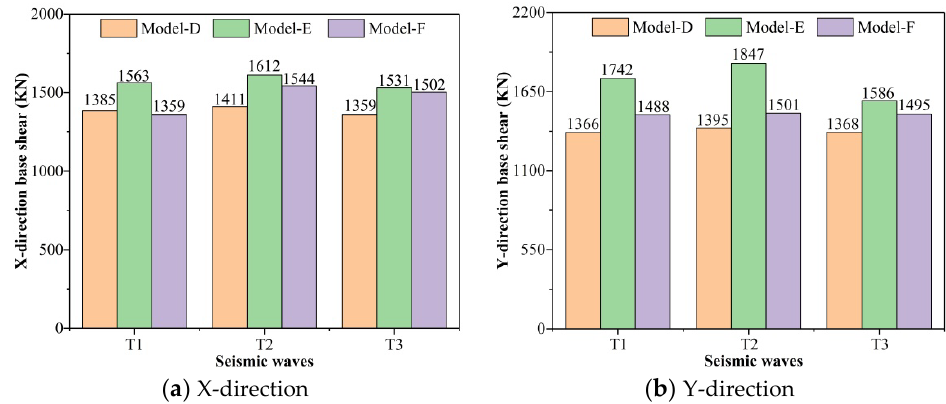
Figure 14. A comparison of the max base shear of the models.